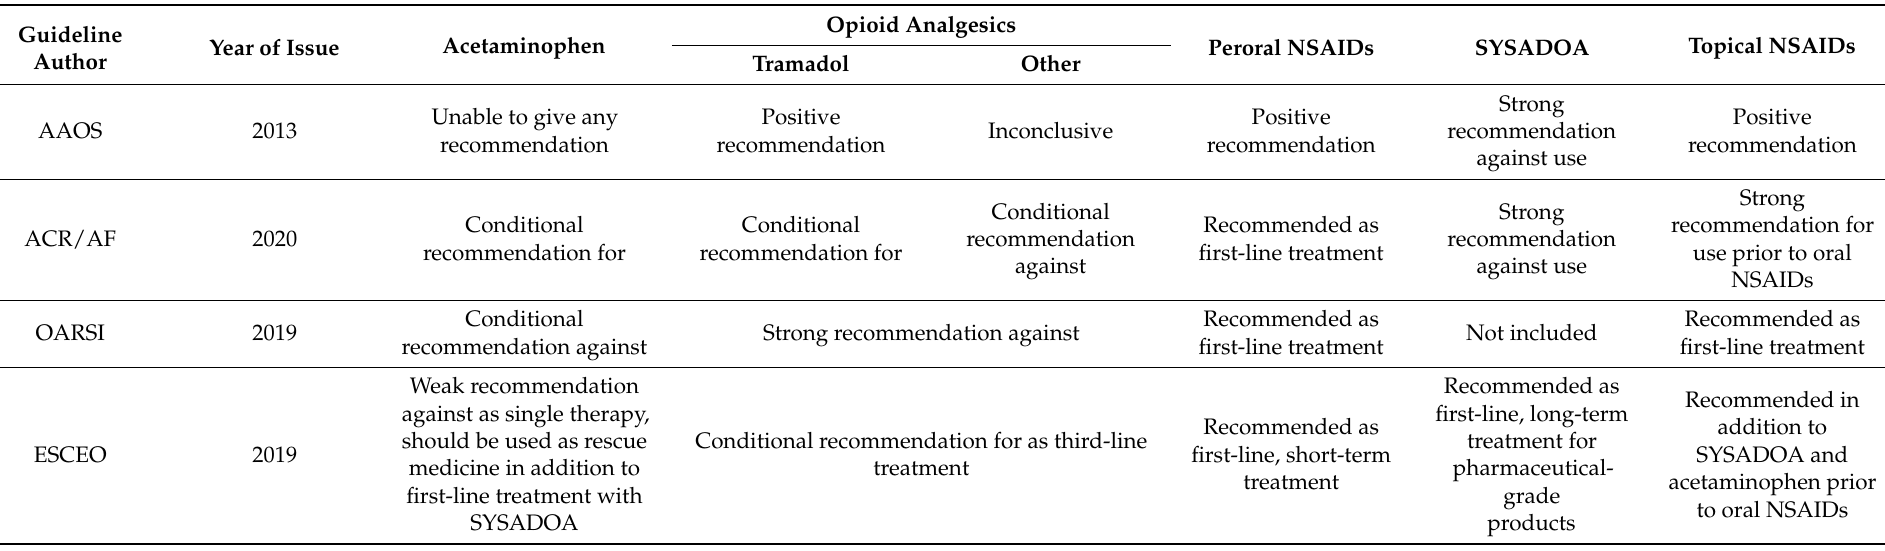
Table 1. Guideline recommendations for most commonly used oral and topical pharmacological agents in osteoarthritis